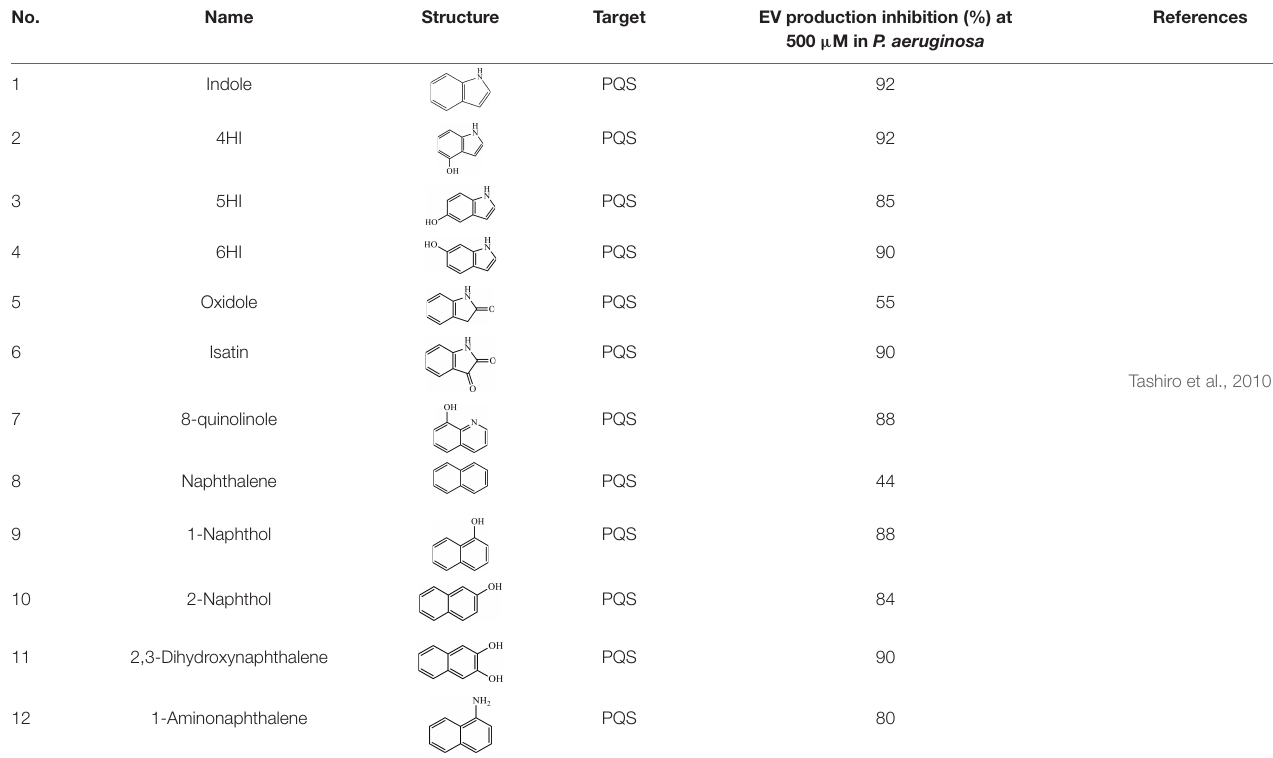
TABLE 1 | EV production inhibitors that targeting